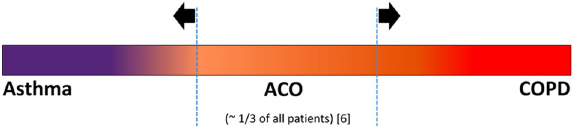
Fig. 2 Schematic illustration of the spectrum of chronic obstruc- tive airways disease diagnoses. The current study focusses on the parts to the left and right of the vertical dotted lines as indicated by the arrows. ACO asthma-COPD overlap, COPD chronic obstructive pulmonary disease.